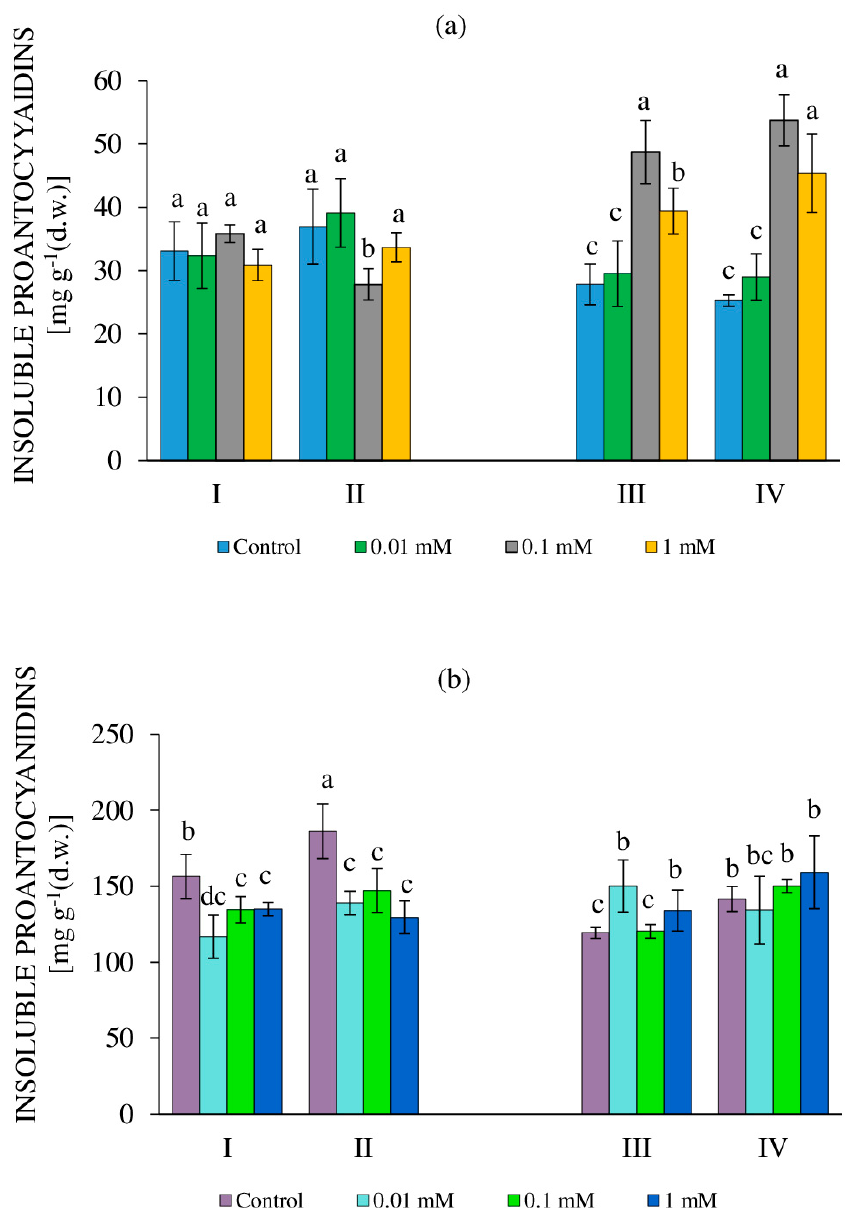
Figure 7. The content of insoluble (bound) proanthocyanidins in callus cultures of tea plants at 24 days (I, II) and 36 days (III, IV) of age, grown in the dark ( a ) or in the light ( b ) and exposed to various concentrations of H 2 O 2 —0 (control), 0.01 mM, 0.1 mM, and 1 mM. Variants: I, III—rapid response of callus cells (2 h exposure to H 2 O 2 ); II, IV—delayed response of cells (36 h after exposure to H 2 O 2 ). Different letters indicate significant differences between exposure conditions ( p ≤ 0.05).